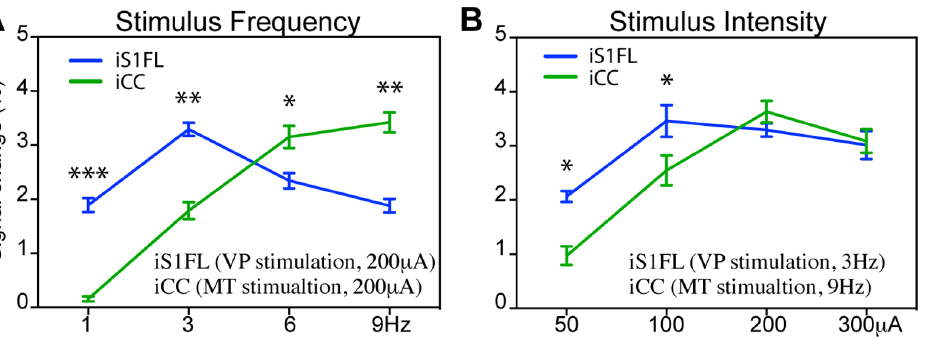
Figure 7. Comparison of evoked BOLD responses between VP and MT stimulation. Mean BOLD response amplitude (mean 6 SEM) in the S1FL (VP stimulation; blue) and CC (MT stimulation; green) at (A) different frequencies (200 m A) and (B) intensities (VP: 3 Hz; MT: 9 Hz). Compared to VP stimulation, the MT required a stronger and higher stimulation frequency to produce an effect (* p , 0.05, ** p , 0.001, *** p , 0.0005, two-way ANOVA with Newman-Keuls